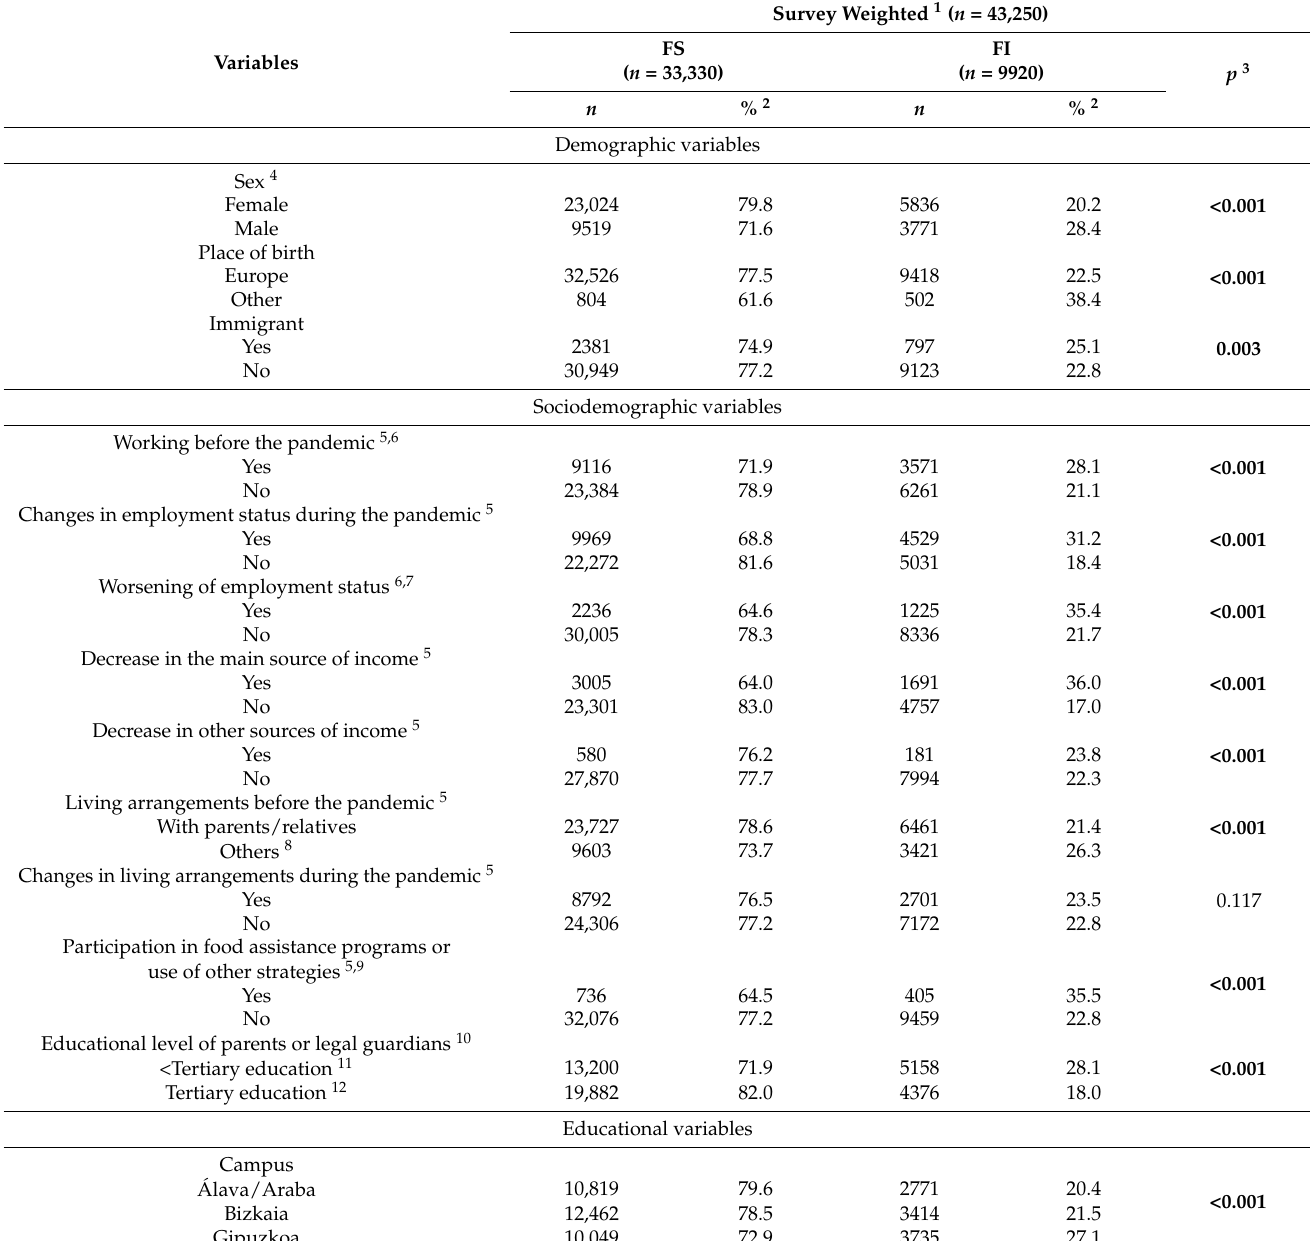
Table 3. Food (in)security status according to demographic, socio-economic, and educational char- acteristics, and weight status in the sample: students of the University of the Basque Country